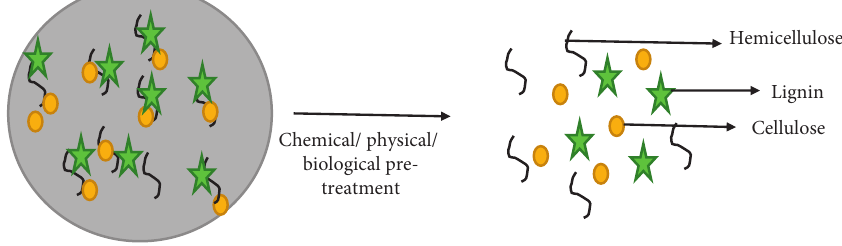
Figure 5: Mechanism of